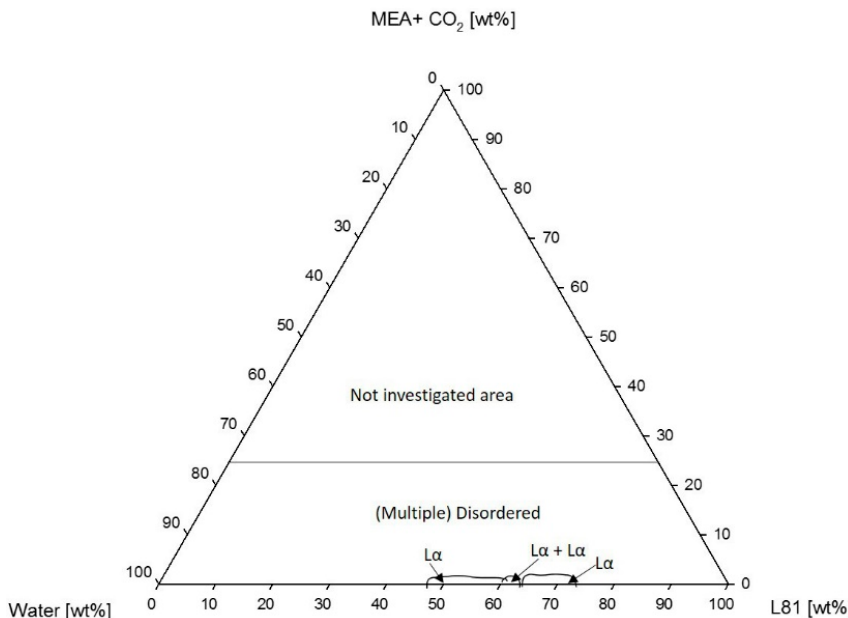
Figure 9. Phase diagram of Pluronic L81/water/MEA + CO 2 .